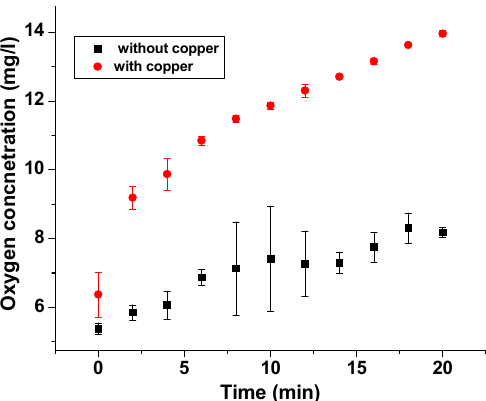
Figure 7 . Dissolved oxygen measurements during the reaction of CuSO 4 (1 mM) and H 2 O 2 (10 mM) (red) and H2O 2 added to ultrapure water (black).